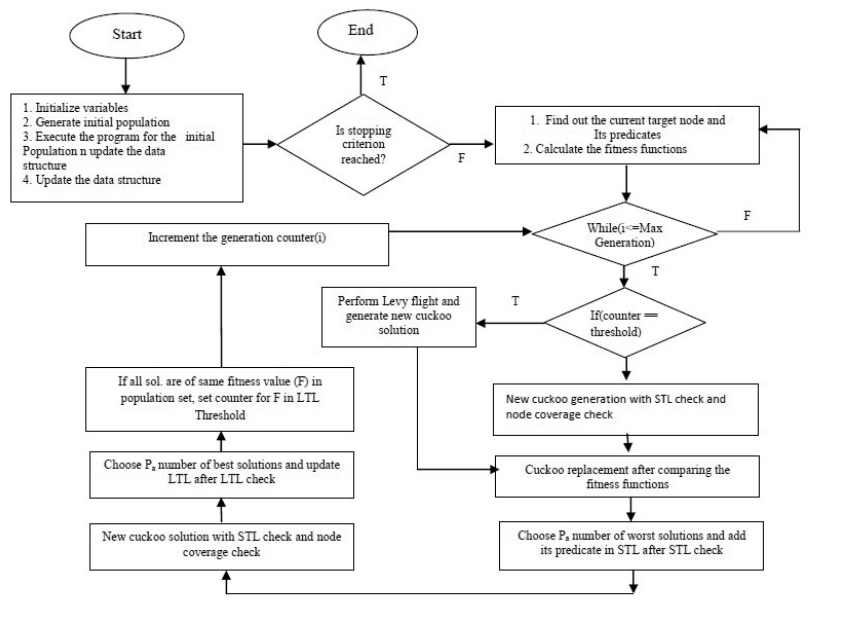
Figure 2. Flow chart of proposed